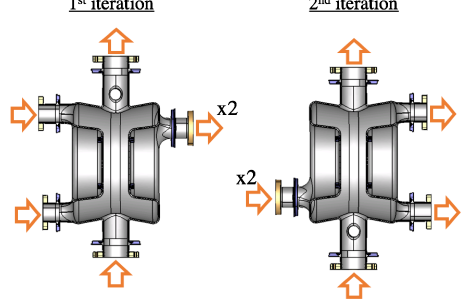
FIG. 8. Bulk BCP of a cavity in two iterations.